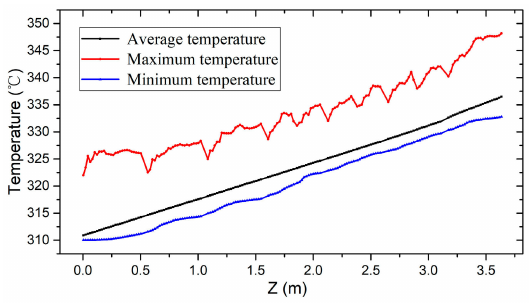
Figure 21. Changes in temperature with